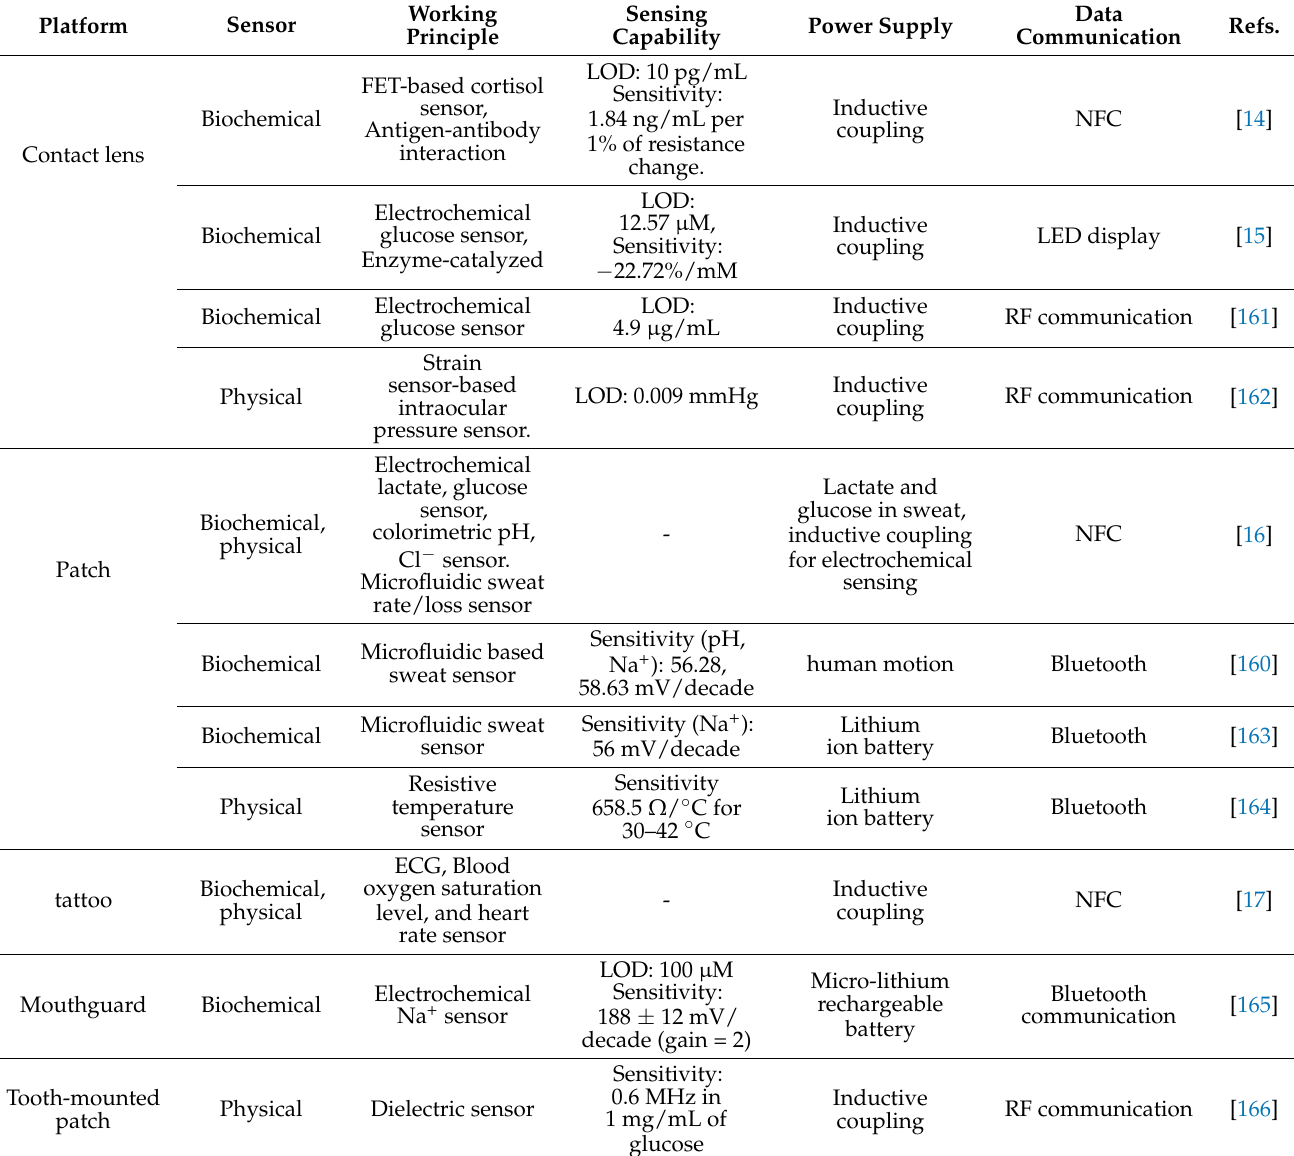
Table 2. Examples of recently reported wearable sensors.